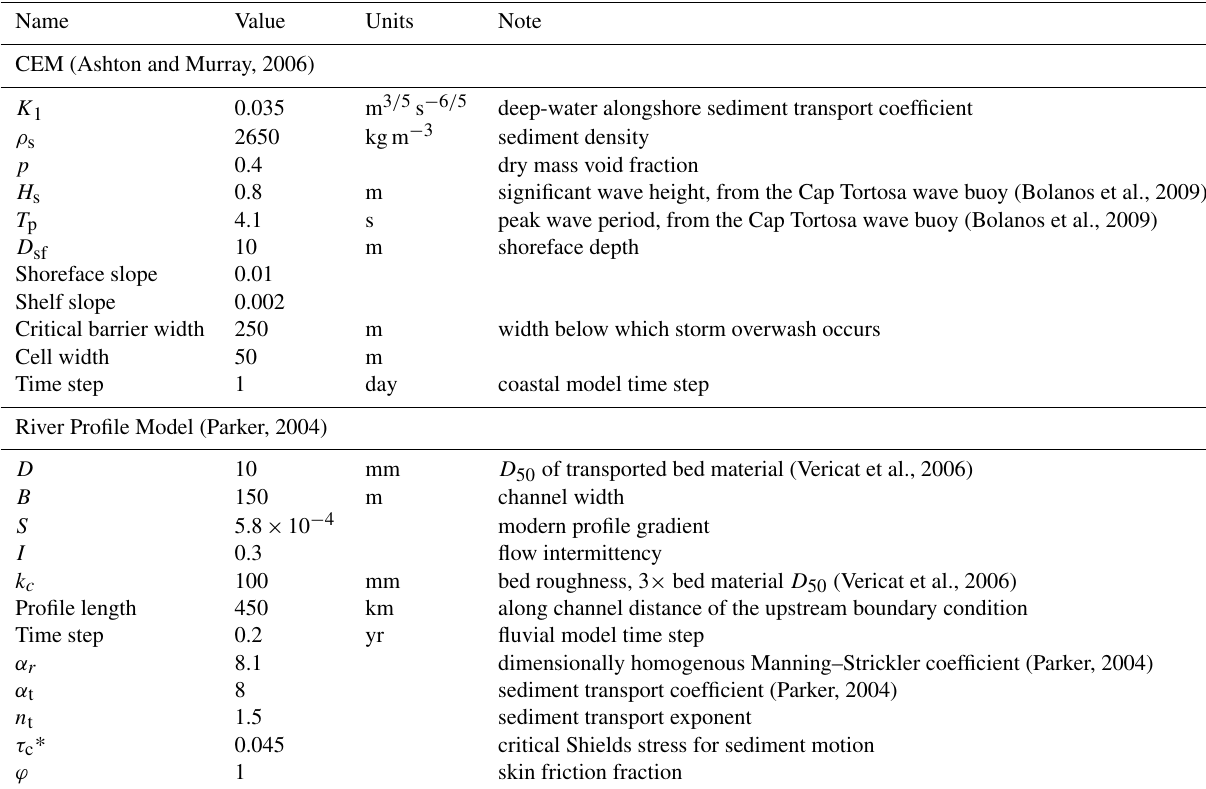
Table 1. Overview of the model parameters chosen for the fluvial and the coastal models. Name